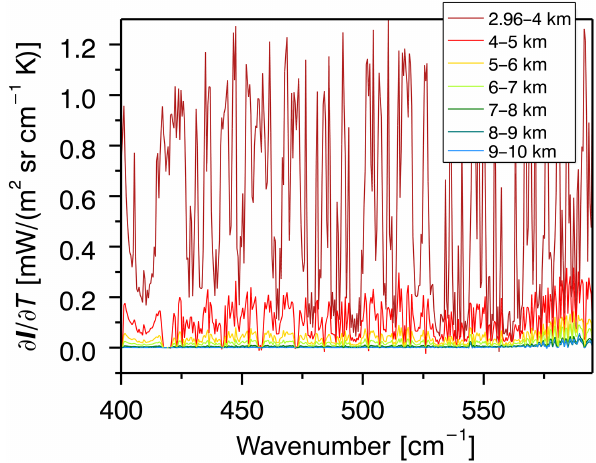
Figure 7. Derivative of surface downwelling radiance with respect to the T profile computed for the mean atmospheric state of the con- tinuum retrieval data set. Color-coding indicates the contributions from different altitude